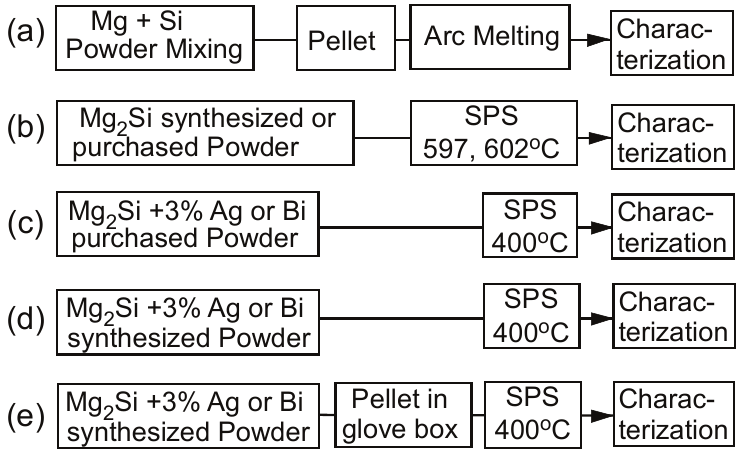
Figure 2. Processing scheme for the different bulk specimens produced in this